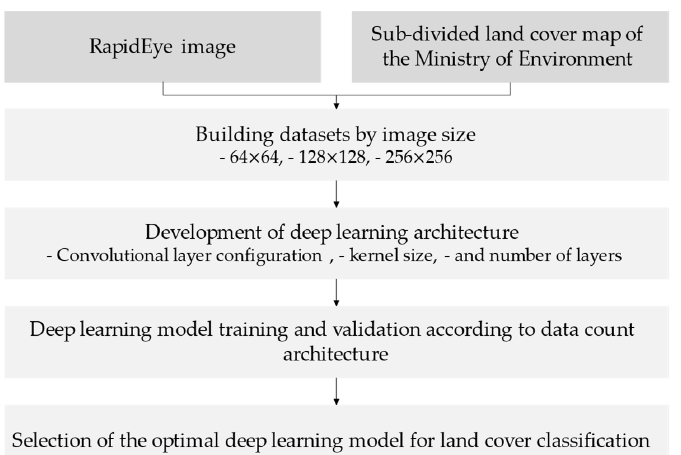
Figure 1. Optimal algorithm development process for land ‐ use and land cover maps.